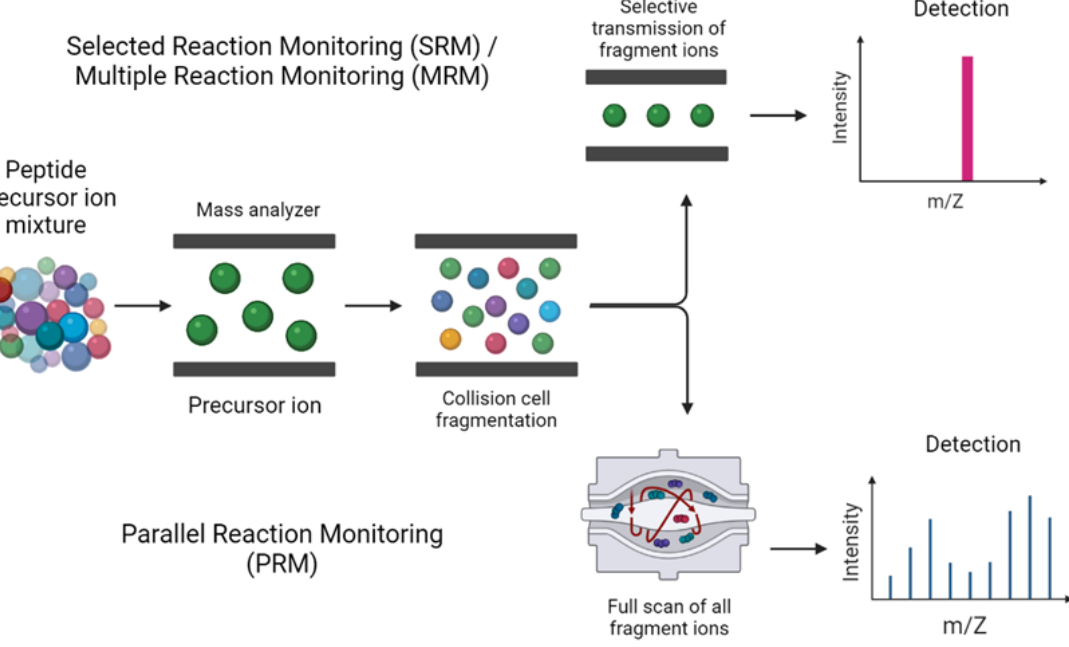
Figure 3. SRM/MRM analysis showing single ion transitions being monitored in comparison to PRM, where a single ion is fragmented from several fragment ions.